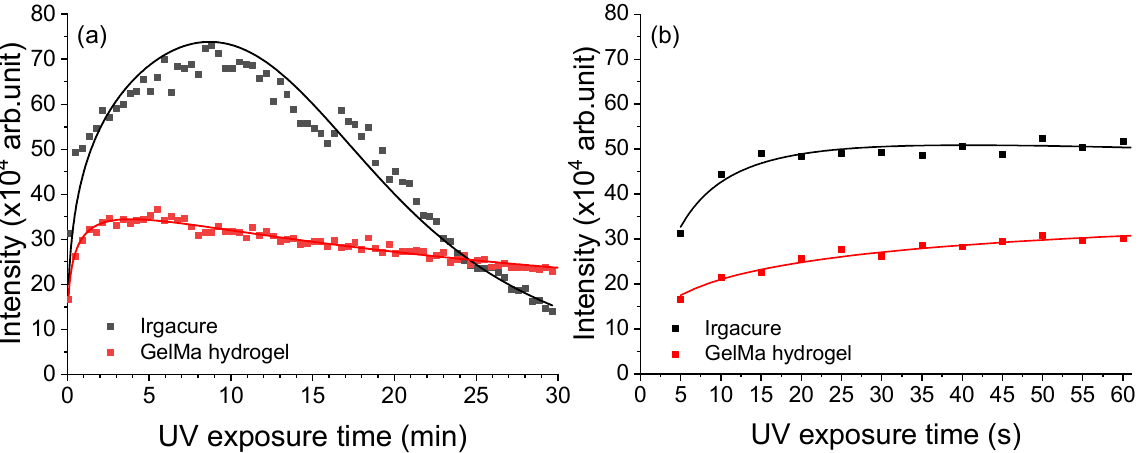
Figure 5. LIF spectra of Irgacure (0.05% w / v ) and GelMa hydrogel (Irgacure 0.05% and GelMa 10% w / v ) exposed to 266 nm laser pulsed radiation at an energy of 0.75 mJ up to 30 min.